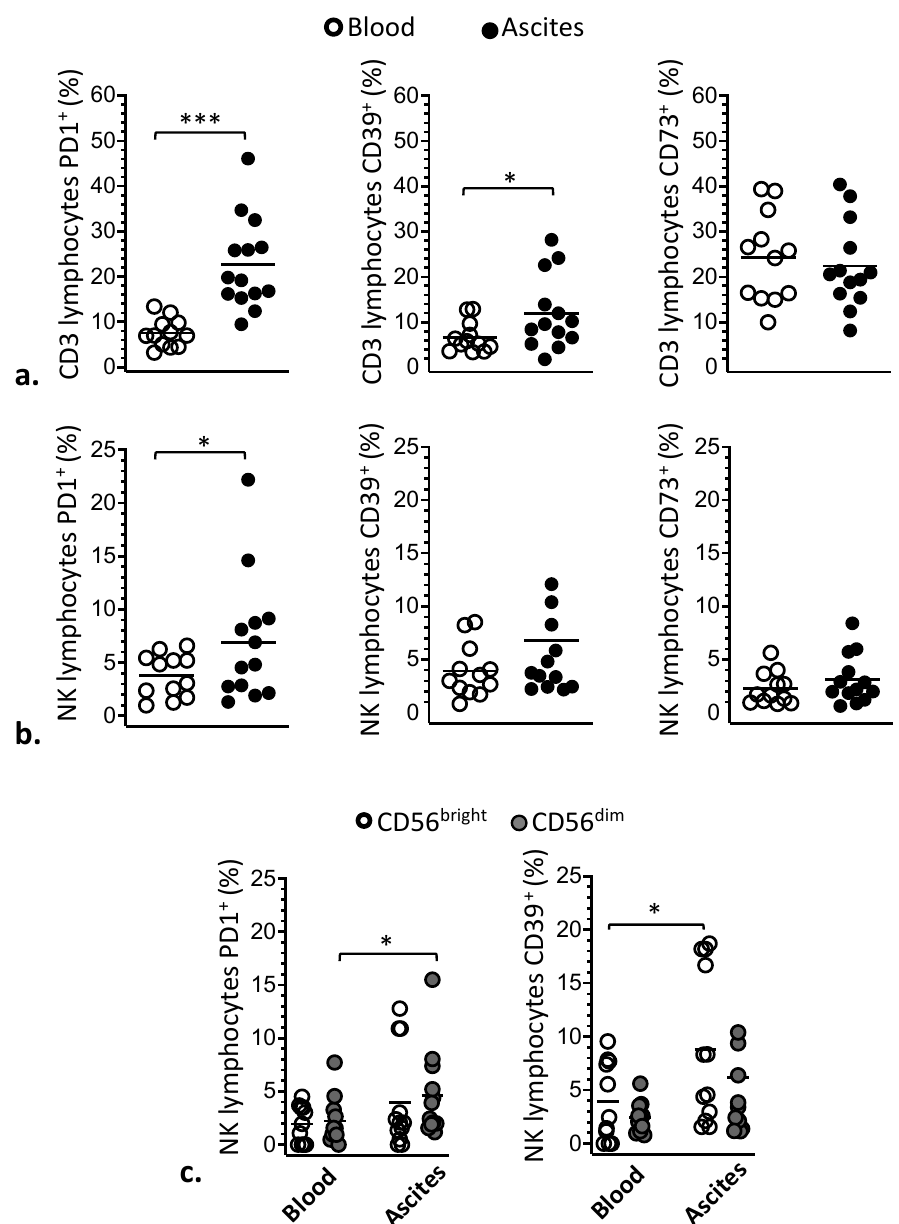
Figure 2. Expression of PD1, CD39 and CD73 molecules on CD3 ( a ) and NK ( b ) lymphocytes from blood (white circle) and ascites (black circle) of women with advanced EOC. Expression of PD1 and CD39 molecules were also assessed in CD56 bright (( c ). white circles) and CD56 dim (( c ). grey circles) subsets of NK lymphocytes from blood and ascites of the patients. Values are presented as percentage of positive cells and mean. Statistical analyses were performed by unpaired one-tailed Student’s t -test; * p < 0.05 and *** p = 0.0001 values indicate significant statistical differences.